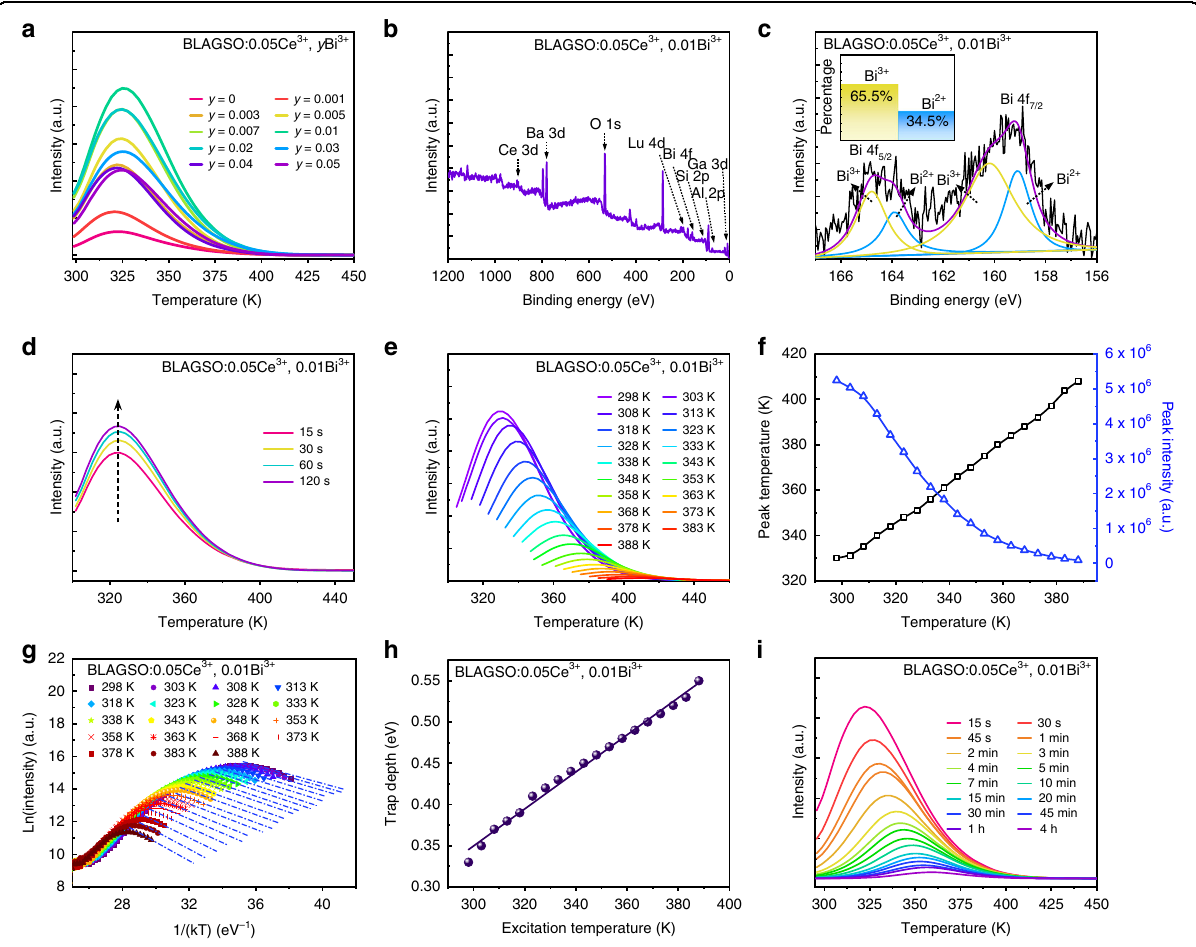
Fig. 6 Thermoluminescence properties. a TL curves of BLAGSO:0.05Ce 3 + , y Bi 3 + measured after 425 nm irradiation for 5 min. b XPS survey scan of BLAGSO:0.05Ce 3 + , 0.01Bi 3 + . c XPS analysis of Bi 4f. Inset: the concentration percentages of Bi 2 + and Bi 3 + . d Excitation duration-dependent TL curves of BLAGSO:0.05Ce 3 + , 0.01Bi 3 + . e Excitation temperature-dependent TL curves of BLAGSO:0.05Ce 3 + , 0.01Bi 3 + . f Dependency on the T exc for I peak and T peak . g Initial rise analysis of BLAGSO:0.05Ce 3 + , 0.01Bi 3 + . h Relationship between calculated trap depth and T exc . i Decay duration-dependent TL curves of BLAGSO:0.05Ce 3 + , 0.01Bi 3